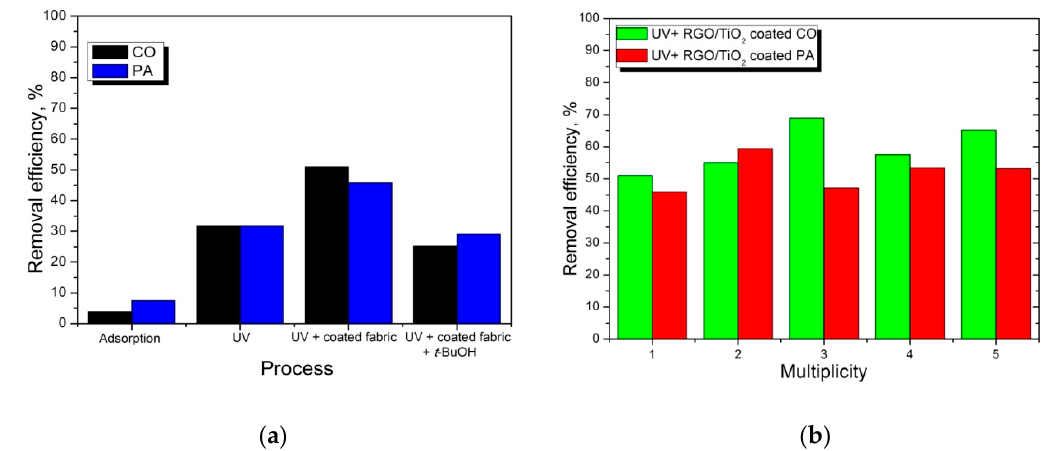
Figure 8. Phenol removal from aqueous solution by various methods ( a ) and multiple applications of RGO / TiO 2 coated fabrics ( b ) in photocatalytic degradation of phenol.